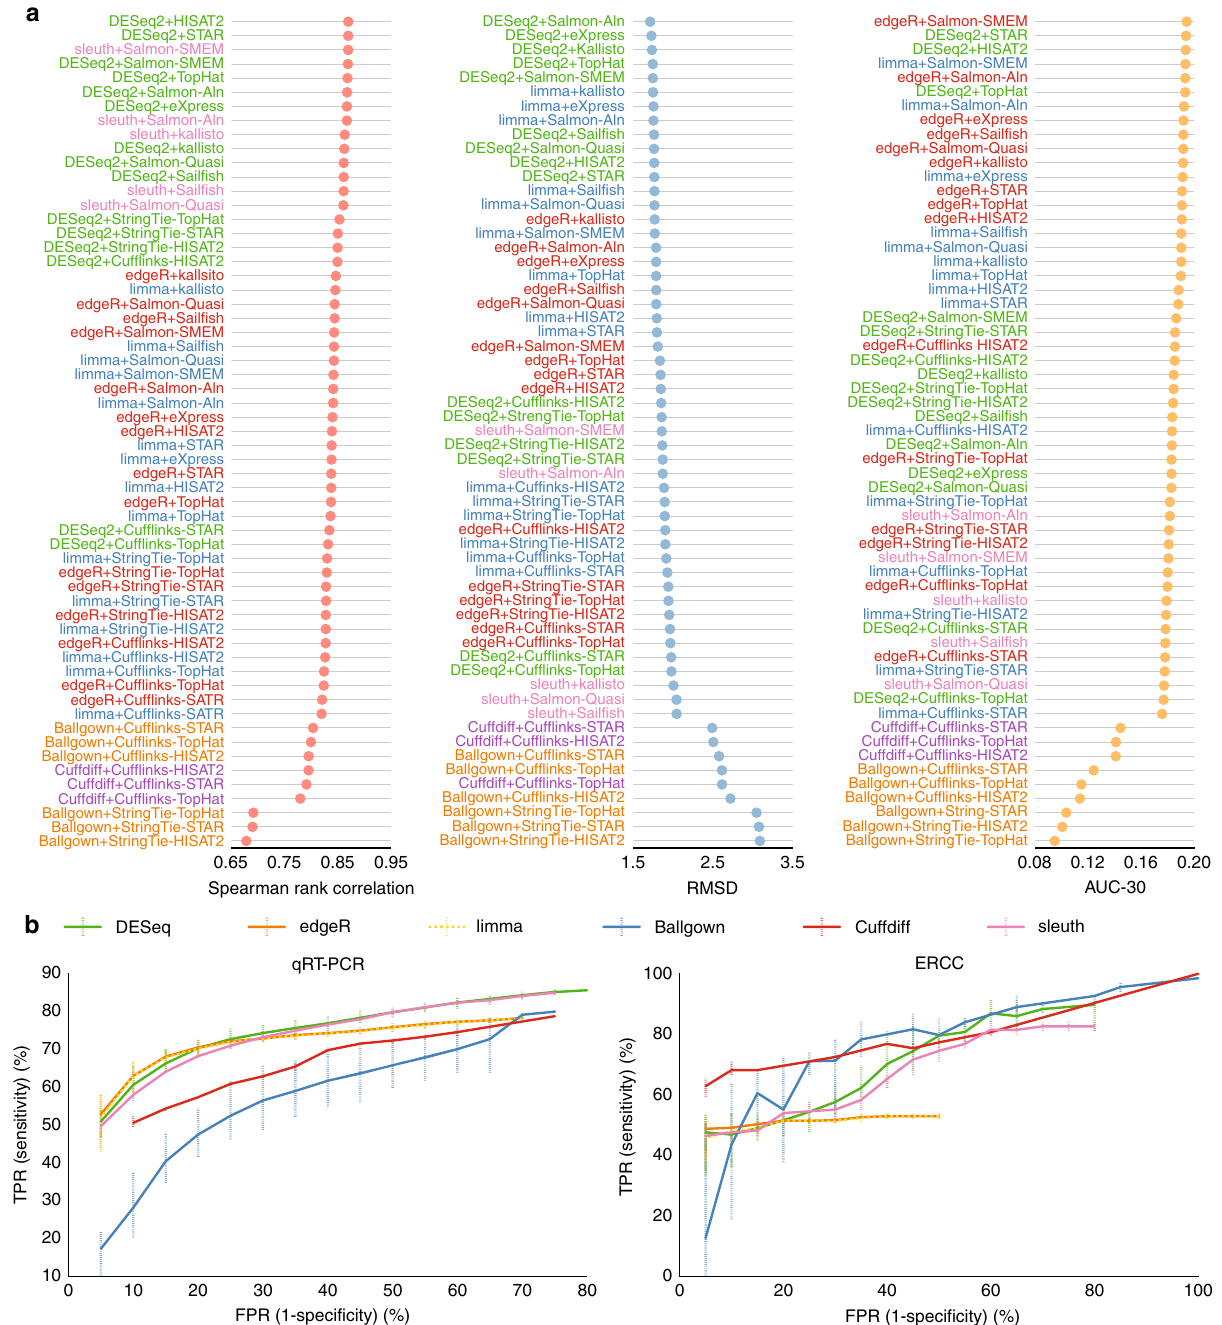
Fig. 6 Performance of differential gene expressions analysis tools on SEQC-A vs. SEQC-B samples. a Spearman rank correlation, root-mean-score-deviation (RMSD), and AUC-30 scores for qPCR measured genes. Spearman rank correlation and RMSD scores are measured between the log2-fold change of the qRT-PCR and RNA-seq tools. AUC-30 score represents the area under the ROC curve up to the false positive rate of 30%. b ROC analysis of qRT-PCR measured genes ( left ) and ERCC ( right ) genes. For each differential analysis tool the plot re fl ects average performance when different alignment-based and alignment-free tools are used for abundance estimation and error bar shows the maximum and minimum variations. Results for each tool combination are shown in Supplementary Figs. 30 and rate of 30% (AUC-30) measure, edgeR outperformed other (Fig. 6b; Supplementary Figs. 29, 35 – 38). In terms of the techniques and increased its superiority if the true positive log2- Spearman rank correlation measure, edgeR and limma were fold change cutoff was increased more than 0.5 (Supplementary signi fi cantly outperfromed by other schemes. For both Spearman Figs. 32 – 34). rank correlation and RMSD measures, DESeq2 still yielded the best performance, while sleuth outperformed edgeR and limma. On AUC-30 measure, however, Cuf fl inks with Ballgown out- Control Consortium (ERCC) spike-in genes in the SEQC data set performed other techniques. On the ERCC genes, in general,